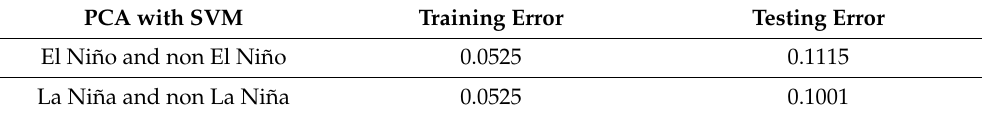
Figure 7. ISOMAP residual variances. The different nearest neighbor numbers in ISOMAP calculation are shown in different colors. Table 1. The training errors and the testing errors from the 20-dimensionality PCA with SVM.